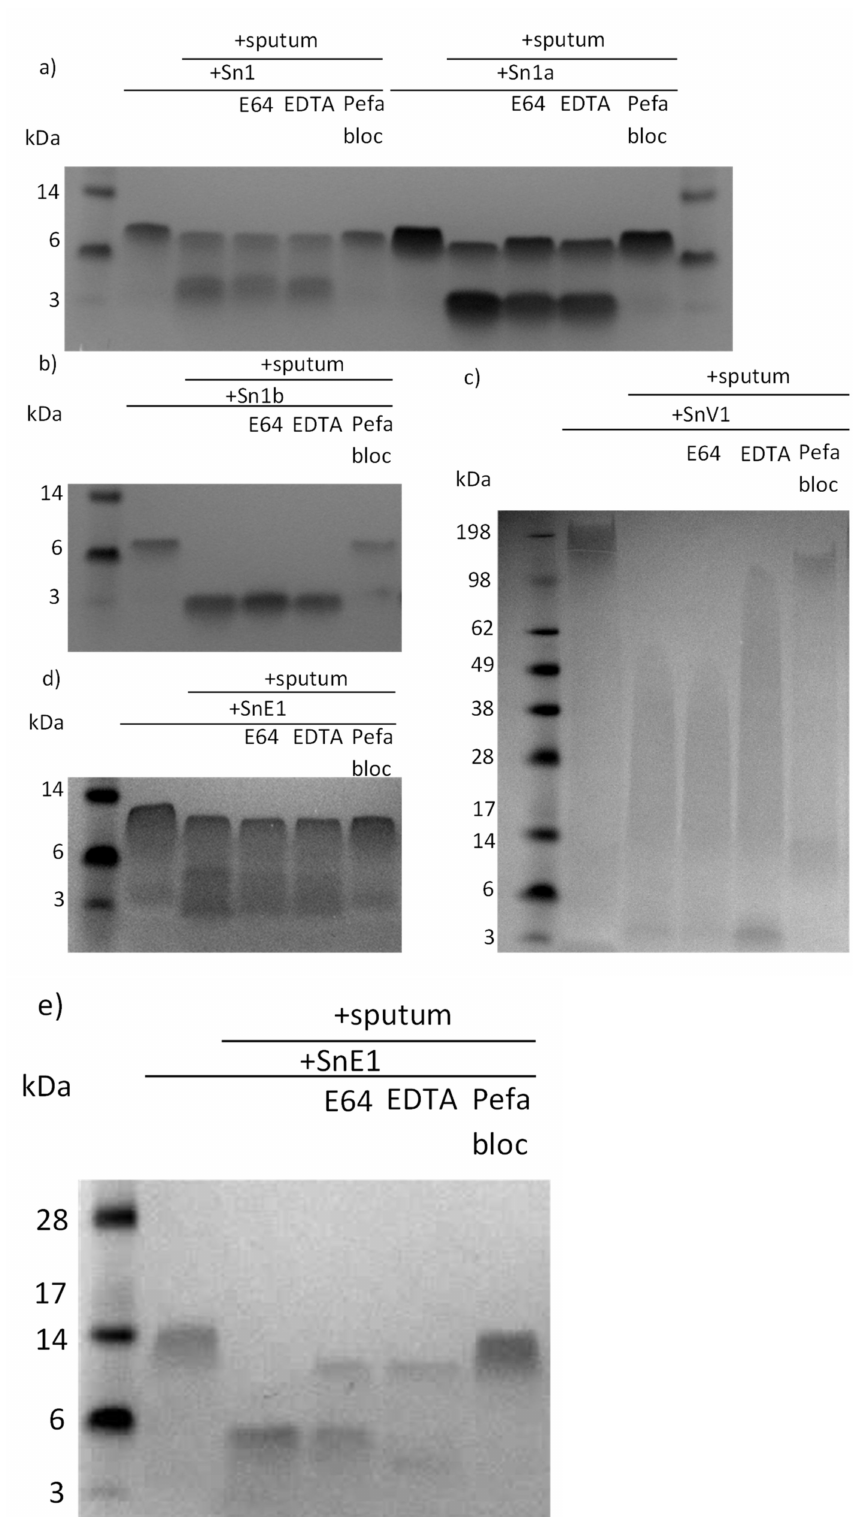
Figure 2. SDS-PAGE gels of peptides incubated with CF sputum in the presence/absence of protease inhibitors. An aliquot of 500 µ g/mL of ( a ) Sn1, Sn1a, ( b ) Sn1b ( c ) SnV1, or ( d ) SnE1 was incubated with CF sputum in the presence/absence of E64 (cysteine protease inhibitor), EDTA (MMP inhibitor) or pefabloc (serine protease inhibitor) for 4 h. An aliquot of 500 µ g/mL of ( e ) SnE1 was also incubated with CF sputum and inhibitors for 24 h. The samples underwent electrophoresis and stained with Coomassie stain to allow